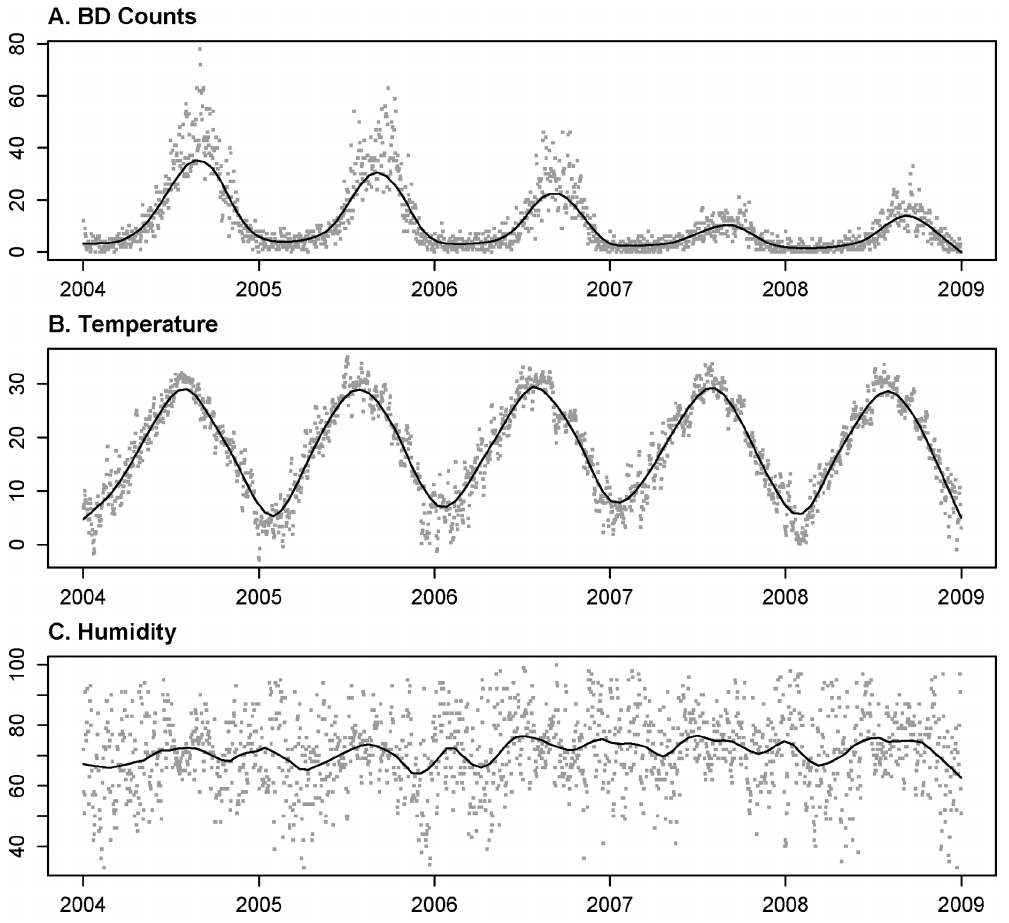
Figure 1. Scatter plot s of BD counts, Temperature and Humidity vs. Time. A. Daily BD counts from 2004 to 2008, with the solid line: Lowess estimation of BD counts. B. Daily averaged temperature from 2004 to 2008, with the solid line: Lowess estimation of averaged temperature. C. Daily averaged humidity from 2004 to 2008, with the solid line: Lowess estimation of averaged humidity.